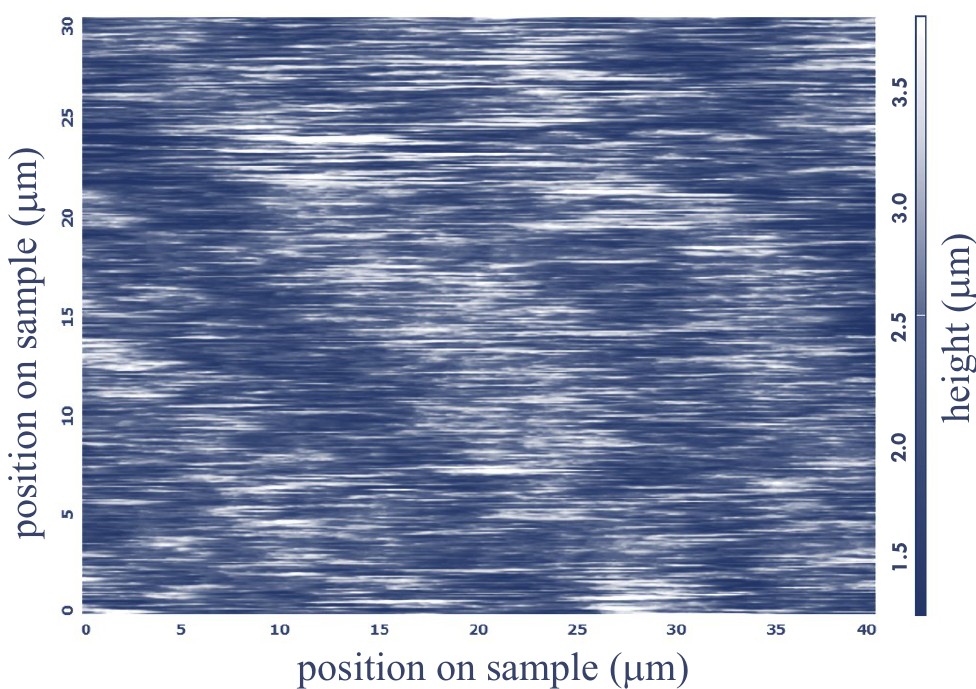
Figure 6. Image of the sample surface obtained using an atomic force microscope. The image size is 30 × 40 microns. The deep blue-to-white contrast scale bar spans a range of 4 µ